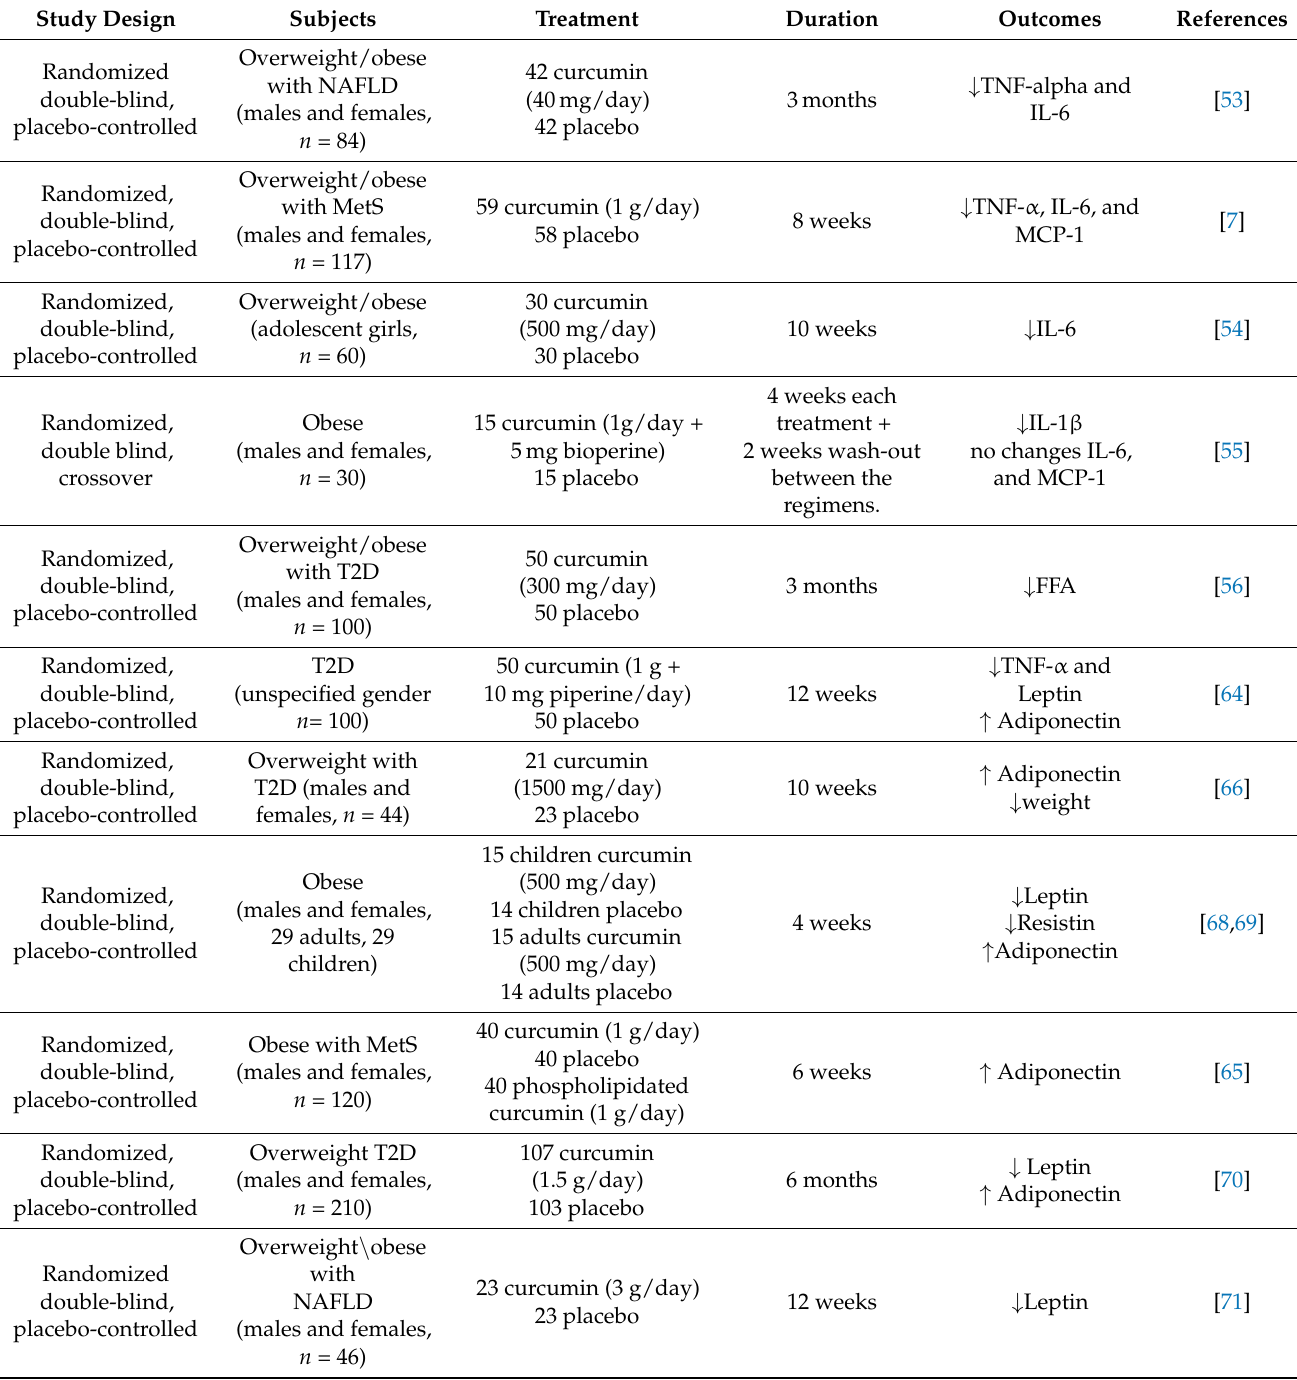
Table 1. Effects of curcumin on inflammation in obesity: human